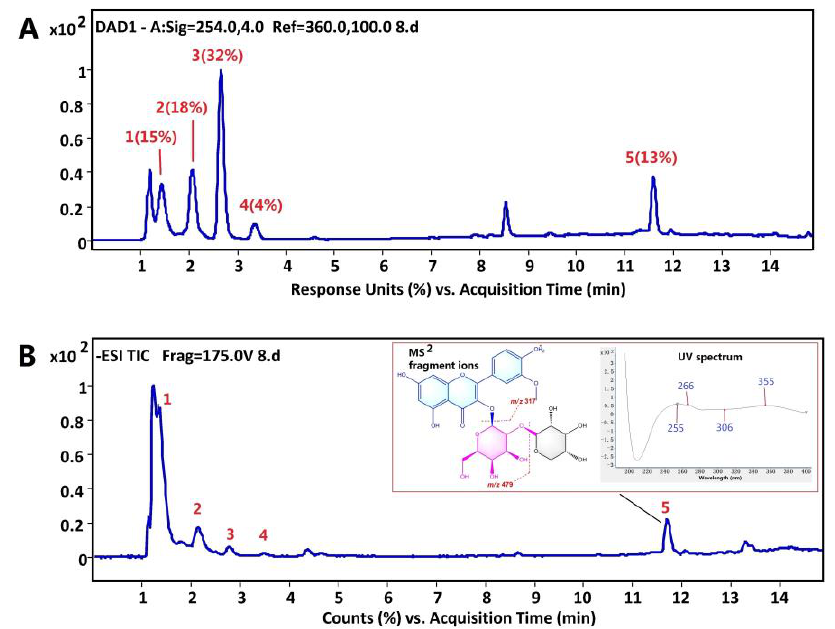
Figure 1. ( A ) UV chromatogram at 254 nm and ( B ) total ion chromatogram in negative mode of LBPE with the insert graphs of (+)MS 2 fragment ions and UV spectrum of peak 5.